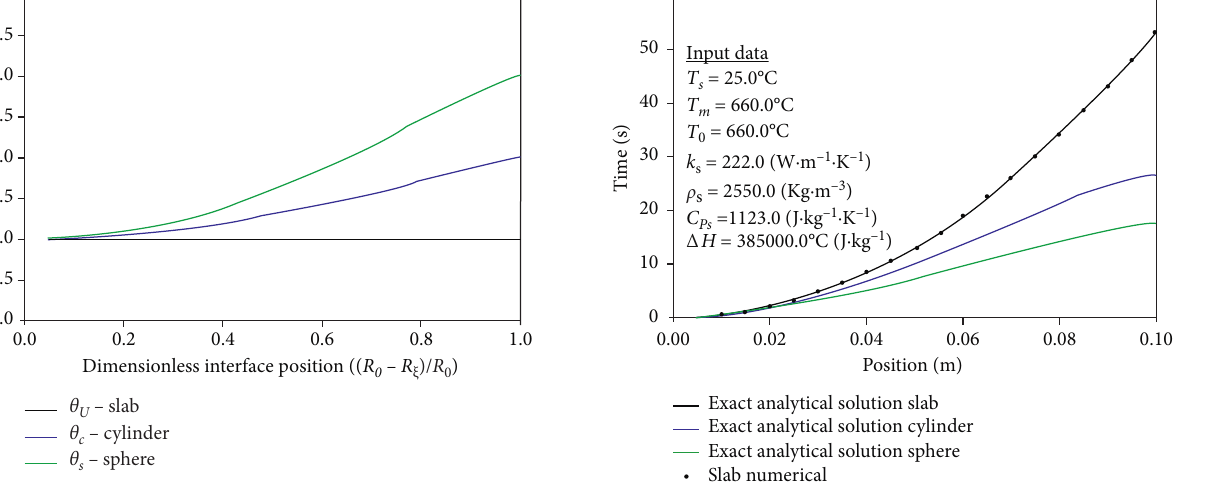
Figure 8: Comparison between numerical and analytical solutions for one-phase solidification times during inward diffusion of a slab, a cylinder, and a